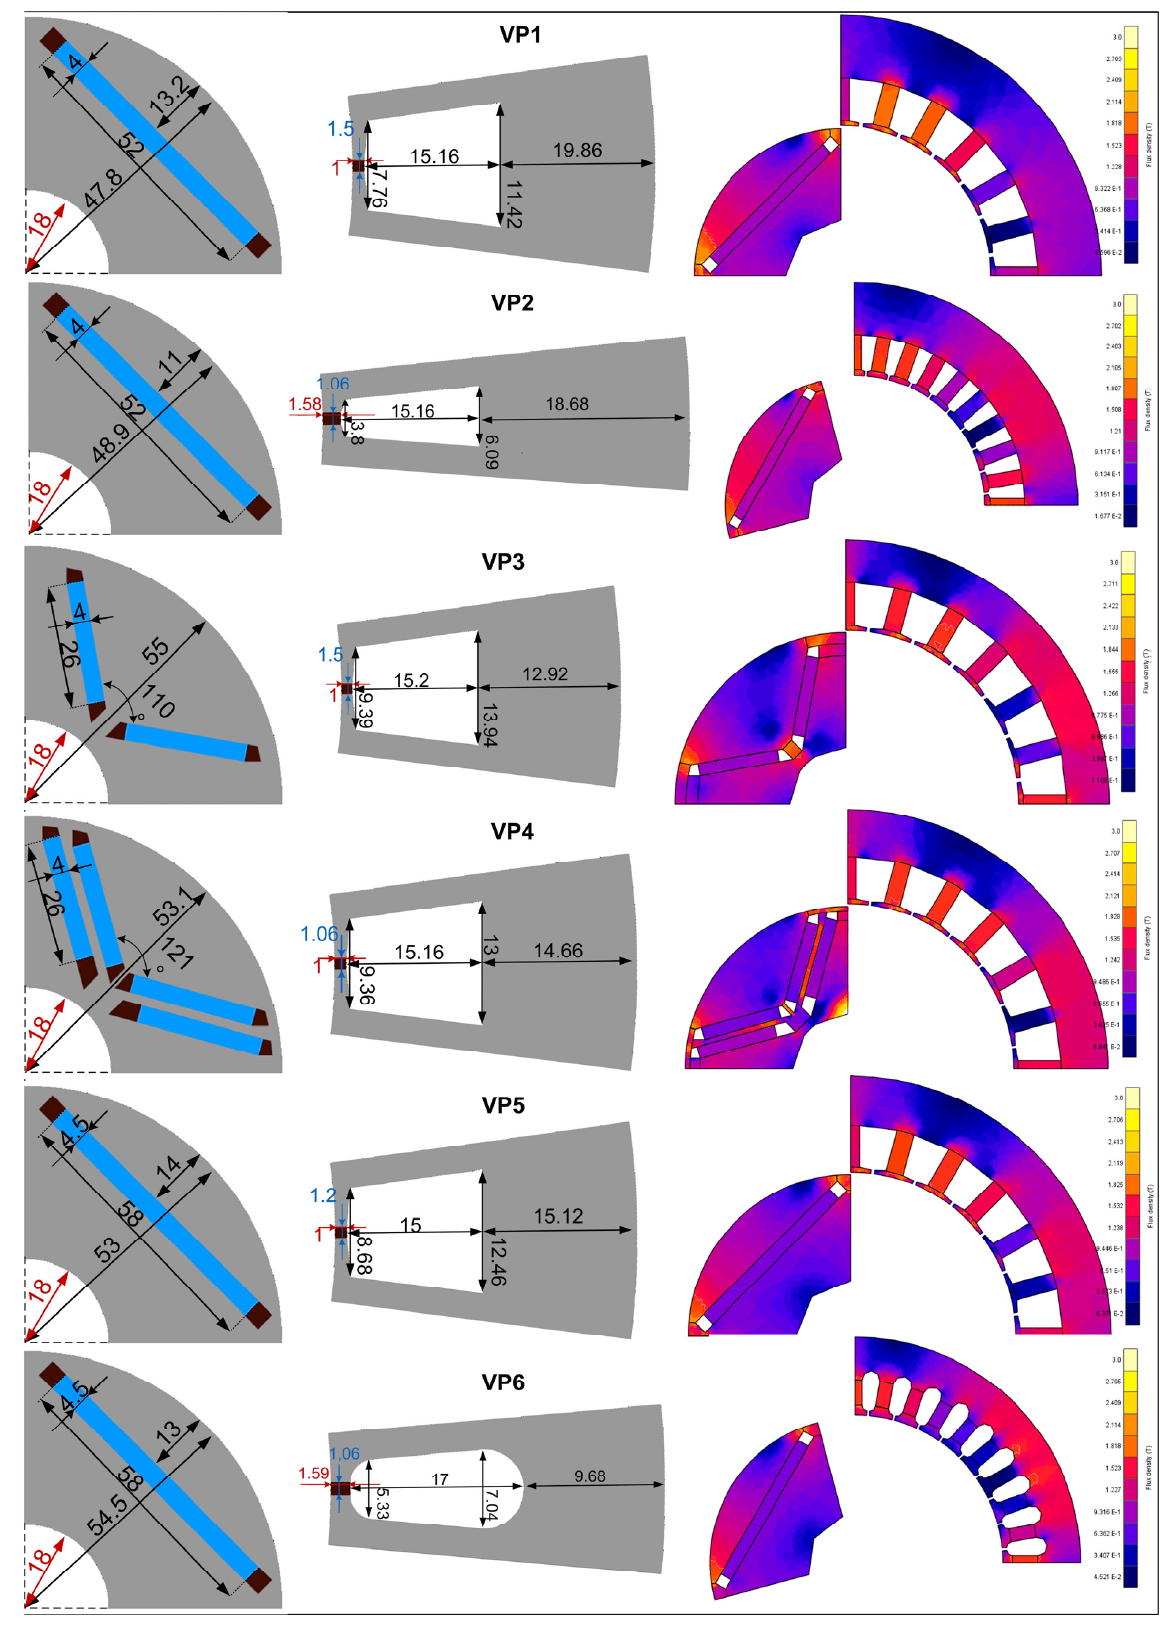
Figure 2. Details of the six considered variants: magnets’ placement (left), stator slot dimensions (center), magnetic flux density distribution (right) .